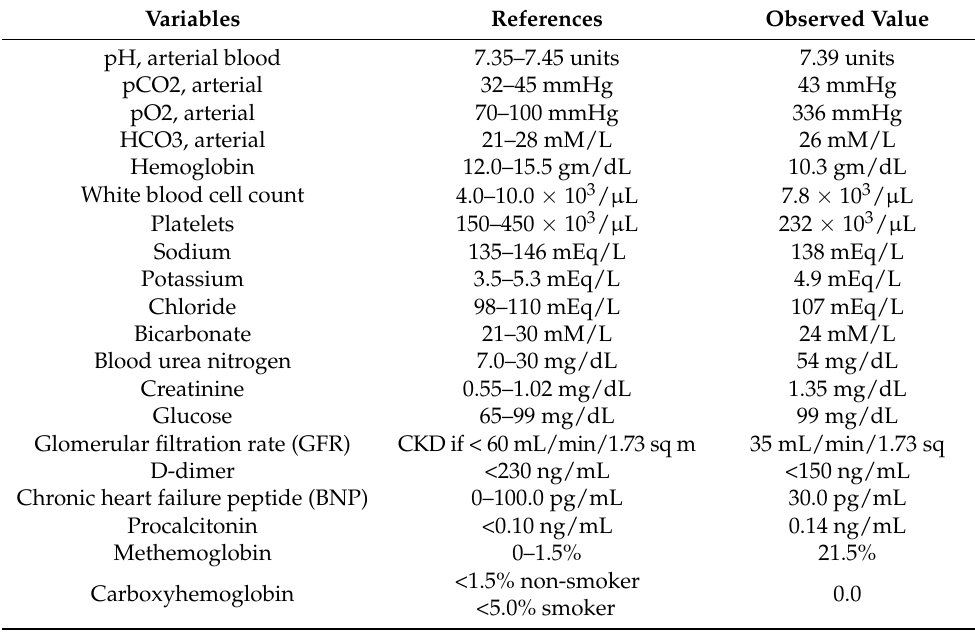
Table 1. The laboratory workup at the day of